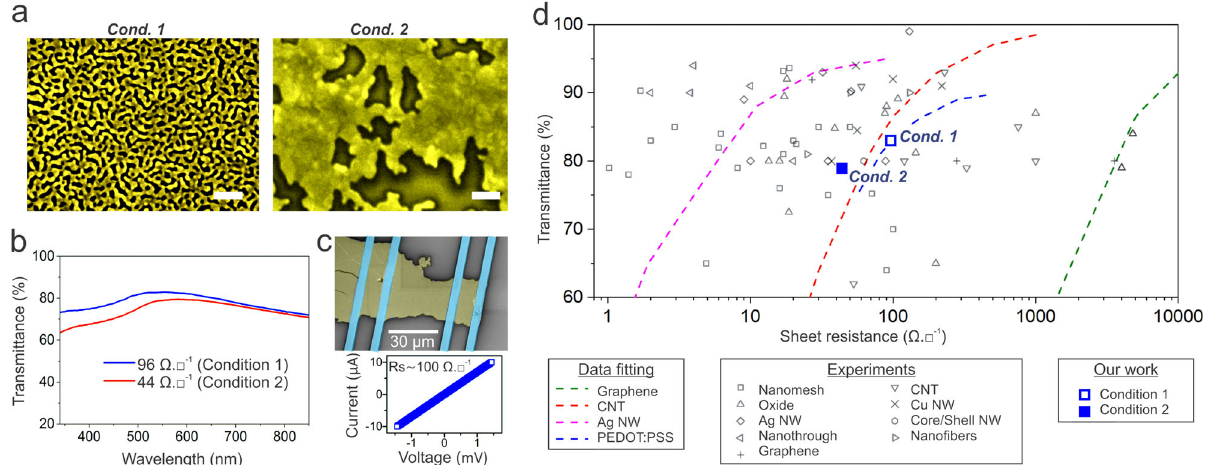
Fig. 2 Morphology and optoelectronic properties of the Au nanomesh electrodes. a Top-view SEM images showing two examples of the typical morphologies of gold nanomeshes prepared using Au-Cu ultra-thin fi lms with 17 at.% of initial gold content and 5 nm initial thickness with different exposure time: (condition 1) 120 min acidic exposure and (condition 2) 15 min acidic exposure. Scale bar: 200 nm. b Example of two UV-Vis transmission spectra of Au nanomesh electrodes on PET with the different values of sheet resistance; the spectra show relatively fl at curves for the entire visible wavelength range. c False-colors SEM image of four terminal electrical conductivity measurement of a single micro-domain and the corresponding I-V curve recorded at room temperature; the yellow and cyan colors represent the gold nanomesh and the platinum electrodes, respectively. d Optical transmission at 550 nm versus sheet resistance of Au nanomesh electrodes on PET prepared with 17 at.% initial gold content and 5 nm initial thickness with different exposure time: 15 min (solid square — condition 2) and 120 min (hollow square — condition 1). For the purpose of comparison, the optoelectronic performances of PEDOT:PSS, carbon nanotubes, graphene, silver nanowires, nanotroughs, copper nanowires, core/shell nanowires, nano fi bers, oxide, and other nanomeshes are also included on the graph. – Inspired by reviews 2,15 - The full list of references used in this fi gure is provided in Supporting Information. Note that the transmittance presented in the graph does not include the transmittance of the